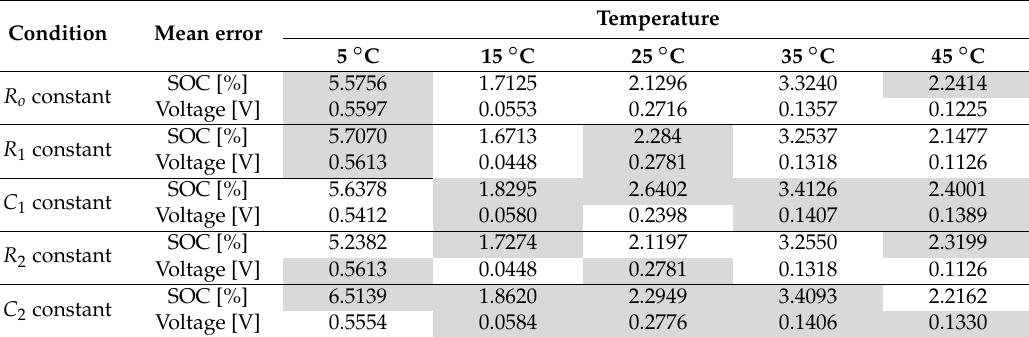
Table 7. Sensitivity analysis of the error of the SOC and battery voltage. Maximum error values (the shaded values represent the instances when the obtained errors, for the case when the average for the parameter was used, are higher than the errors for the case when the dependence on the SOC was